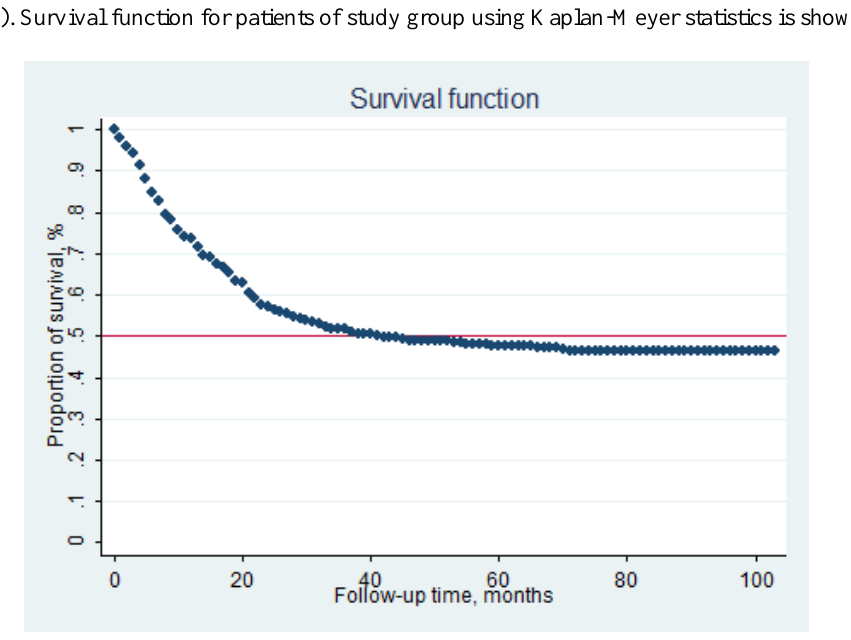
Figure 1. Kaplan-Meyer survival function for oncological patients diagnosed with